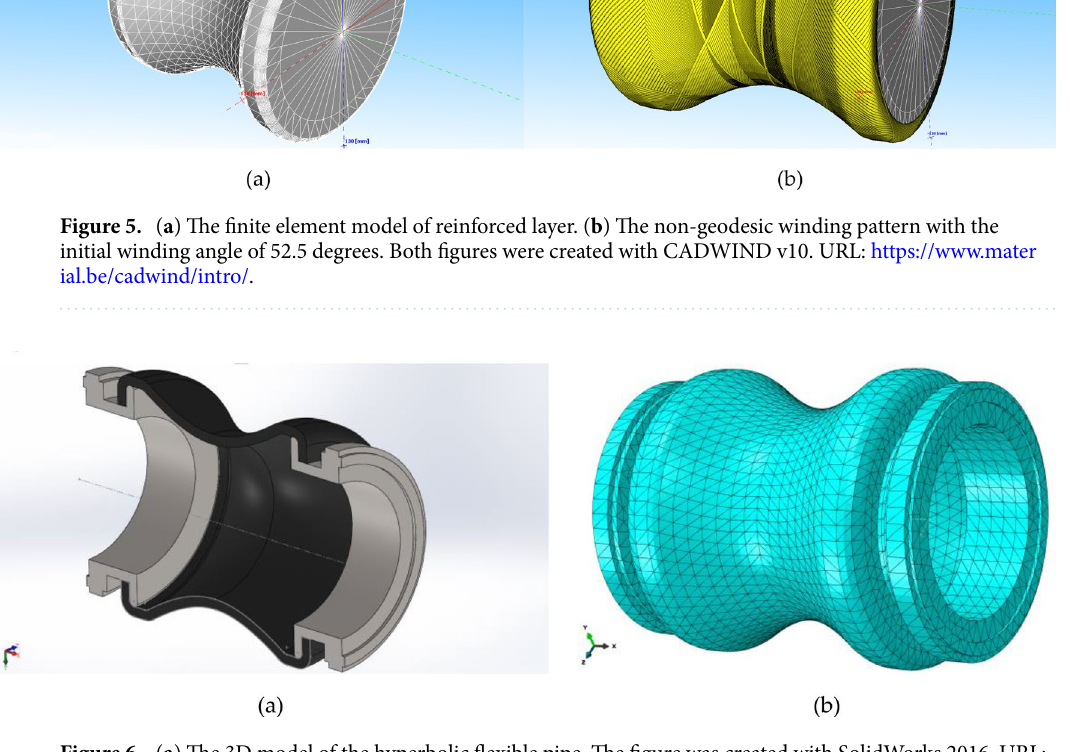
Figure 6. ( a ) The 3D model of the hyperbolic flexible pipe. The figure was created with SolidWorks 2016. URL: https ://www.solid works .com/ ( b ) The finite element model of the hyperbolic flexible pipe. The figure was created with ABAQUS 6.14. URL: https ://www.3ds.com/produ cts-servi ces/simul ia/produ cts/abaqu s/.